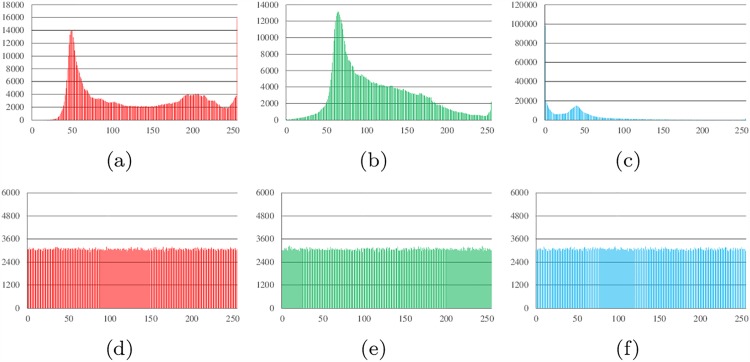
Histogram analysis results of flower.(a) Histogram of red channel of flower; (b) Histogram of green channel of flower; (c) Histogram of blue channel of flower; (d) Histogram of red channel of cipher; (e)Histogram of green channel of cipher (f)Histogram of blue channel of cipher.